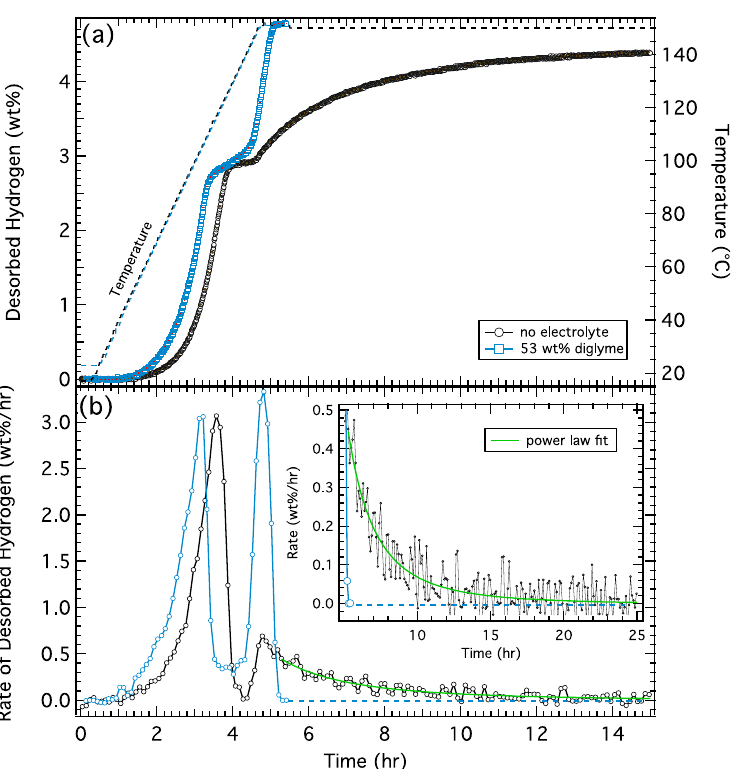
Figure 1. ( a ) Hydrogen desorption from 50/50 wt% NaAlH 4 /diglyme (blue) and NaAlH 4 control samples (black). Corresponding temperature profiles are indicated by the dashed lines. ( b ) Rate of desorbed hydrogen from both samples calculated from the derivative of the desorption curve with a magnified and expanded region of the data set shown in the inset. Green curve is a power law fit to the continuously slowing desorption in the control sample (green) and the dashed blue curve represents an extrapolated rate of the electrolyte sample, which is zero after ~5.4 hrs.